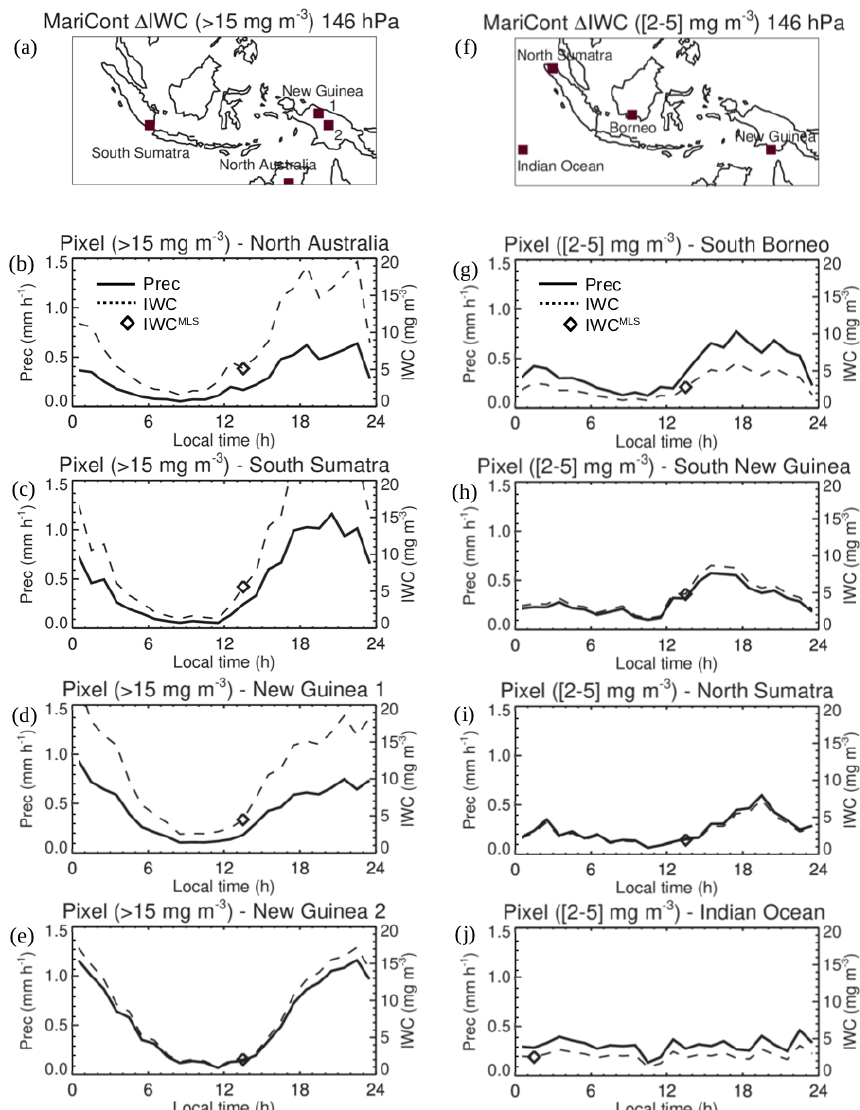
Figure 5. Location of 2 ◦ × 2 ◦ pixels in Fig. 4, where (a) (cid:49) IWC > 15mgm − 3 and (f) 5 > (cid:49) IWC > 2mgm − 3 . Diurnal cycle of Prec (solid line) over four pixels (in Fig. 4), where (cid:49) IWC > 15mgm − 3 (b, c, d, e) and 5 > (cid:49) IWC > 2mgm − 3 (g, h, i, j) , during DJF 2004–2017. The diamond represents IWC MLS during the increasing phase of the convection. The dashed line is the diurnal cycle of IWC estimated from the diurnal cycle of Prec and from IWC MLS